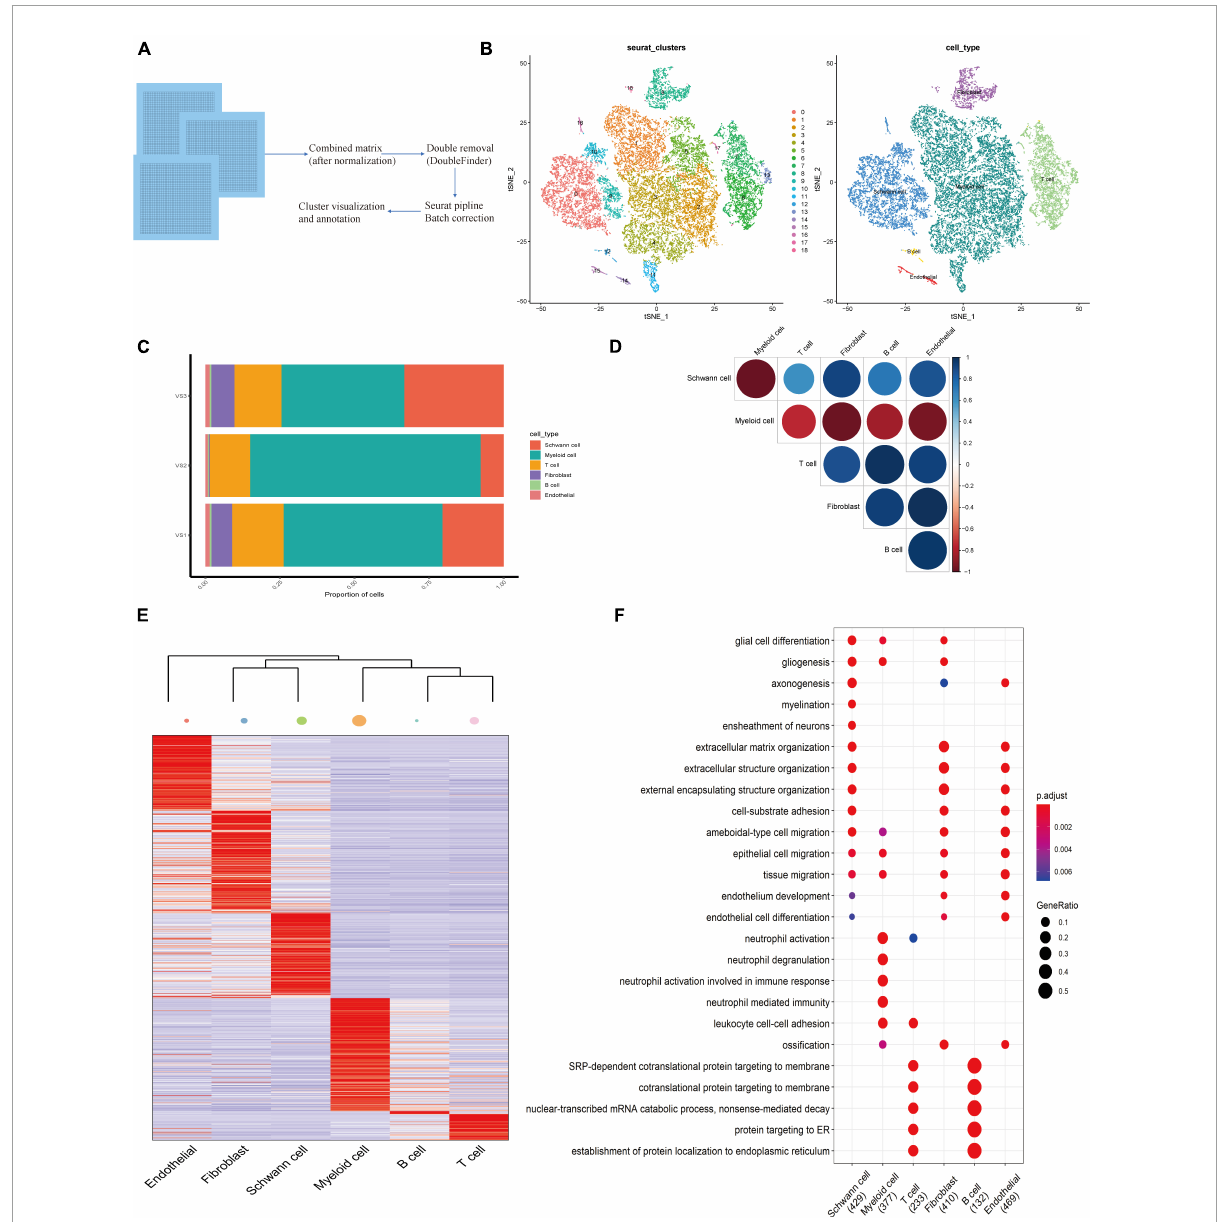
FIGURE1 Establishing of the Cell Atlas for sporadic Vestibular Schwannoma Based on Single-Cell RNA-Seq. (A) An overview of the study design and workflow. (B) Overall cell type composition of 224,309 cells from three sporadic Vestibular Schwannoma patients were visualized with TSNE projection. (C) Correlation circle diagram of 6 subgroups. (D) The heat map shows differentially expressed genes for six cell types in VS. The color keys from purple to yellow indicate low to high expression levels. Typical cell marker gene expression that defines each cluster is shown at the right. (E) The heatmap shows the hierarchical clustering relationship of each cell type, and the size of the point represents the number of cell subsets. (F) The bubble diagram shows the functional enrichment diagram of 6 cell types.